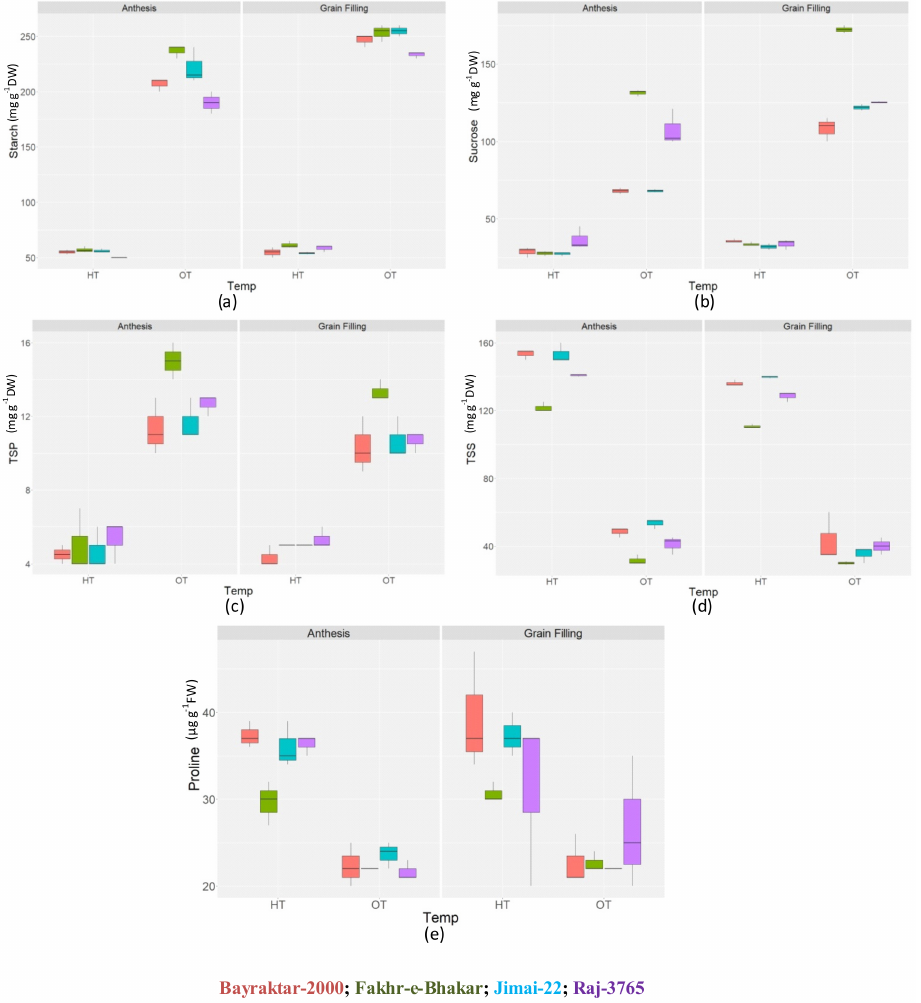
Figure 1. Effects of different regimes of temperature: optimum temperature (OT); high tempera- ture (HT) on different leaf osmolytes of wheat genotypes during grain filling and anthesis stages: ( a ). starch; ( b ). sucrose; ( c ). TSP, total soluble proteins; ( d ). TSS, total soluble sugars; ( e ). proline. Values shown are mean estimates averaged on 3, 5, 7, 9, 11 and 13 days of temperature treatment impositions during tri-replicate experiment at p ≤